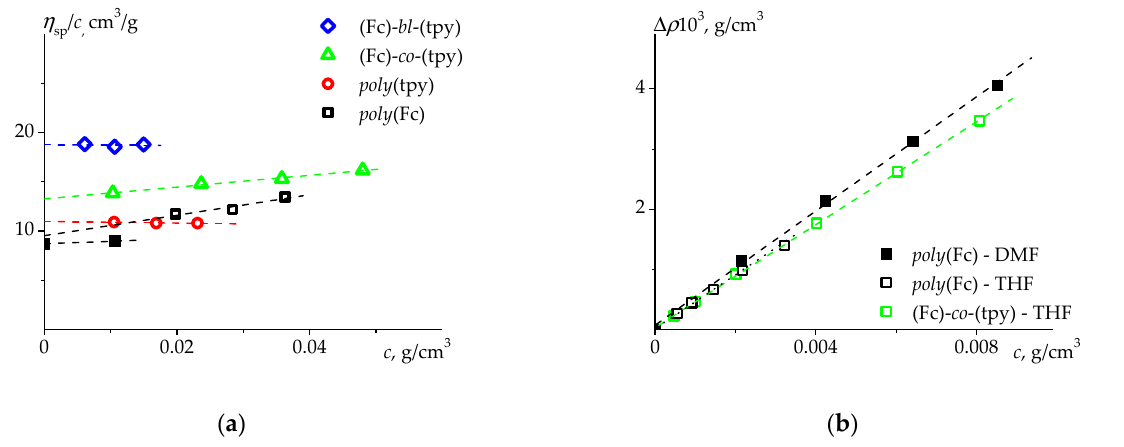
Figure 3. ( a ) The normalized specific viscosity, η sp / c , vs. concentration, c , obtained for the studied polymers in THF (open symbols) and DMF (filled symbols) at 20 °C. ( b ) The dependence of ∆ ρ = ρ − ρ (cid:2868) on the polymer concentration, 𝑐 , determined for poly (Fc) and (Fc)- co -(tpy) at 20 °C.